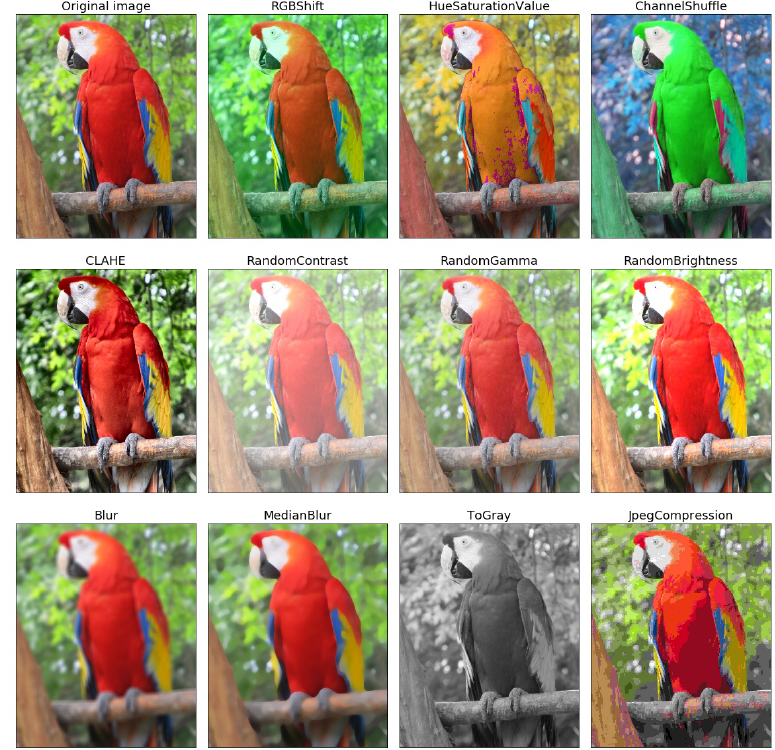
Figure 1. Exemplar applications of image transformations available in